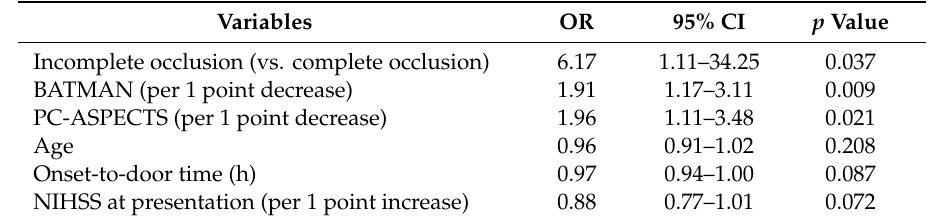
Table 4. Logistic regression model for prediction of neurological deterioration in vertebrobasilar occlusion patients that did not undergo endovascular